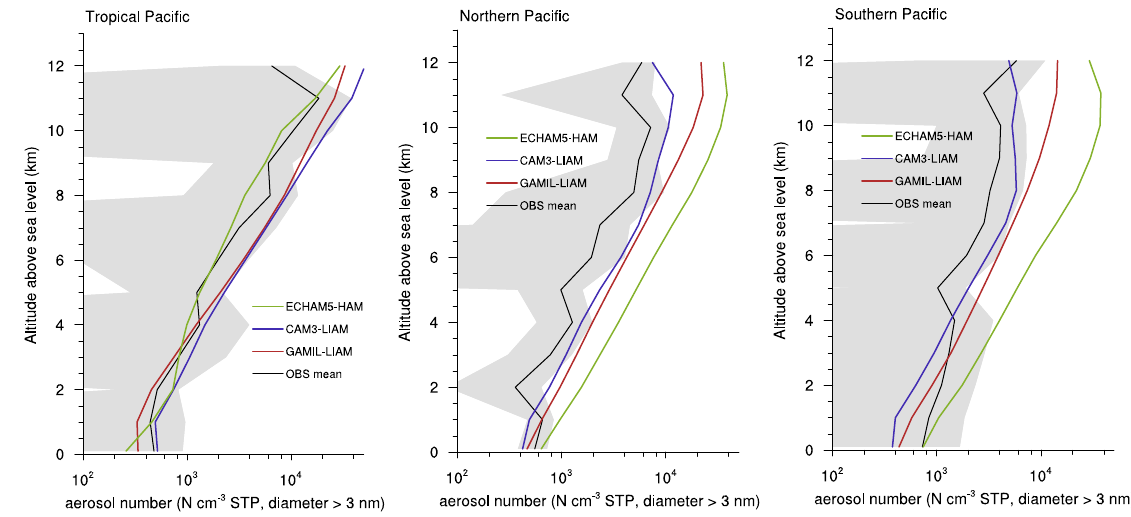
Fig. 9. Comparison between the simulated and observed particle number concentrations over the tropical (left), northern (middle) and southern (right) Pacific regions. The simulated profiles are derived from the total ( D p > 3nm) aerosol number concentrations averaged over the ocean grid points in the blue boxes shown in Fig. 8. The observations were compiled by Clarke and Kapustin (2002) from measurements obtained in the 1990’s (see Fig. 9 therein). The grey shading indicates the standard deviation of the observed